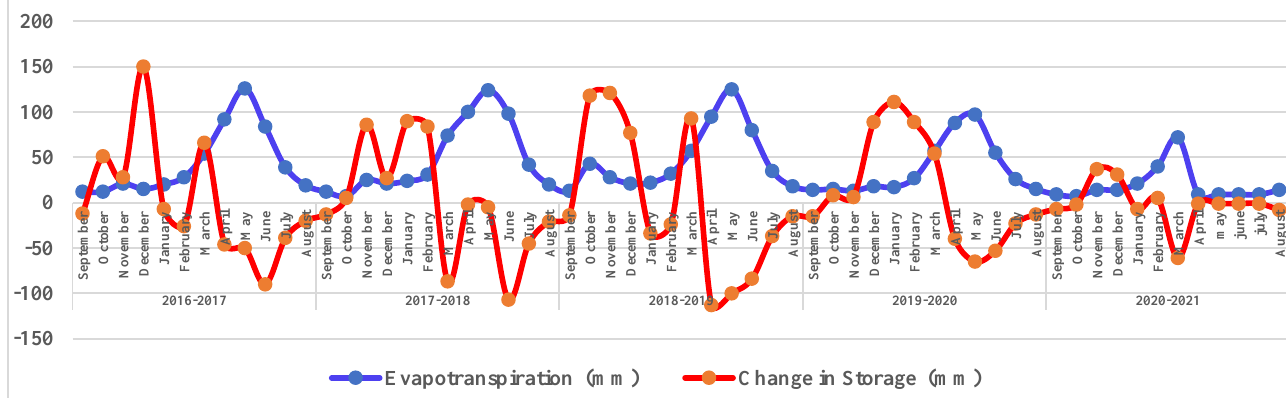
Figure 7. The effect of evapotranspiration on change in